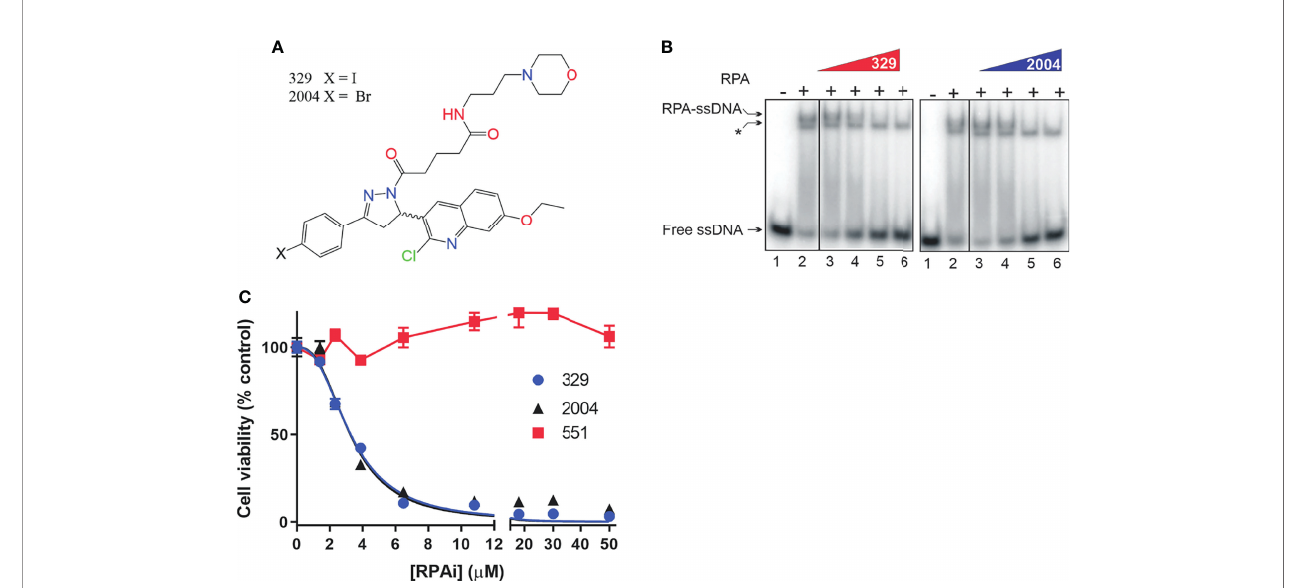
FIGURE 2 | Replication protein A inhibitor(RPAi) inhibitory activity. (A) Chemicalstructure of RPAi ’ s 329 and 2004 . (B) EMSA analysisof RPA – DNA interaction inhibition by 329 and 2004 . Lanes 3 – 6 ineach panelcontain 6.25, 12.5, 25, and 50 µM of the indicated RPAi,respectively.The * indicates the position of the Escherichia coli SSB – single- stranded DNA (ssDNA)complex that serves as an internal speci fi city control. (C) Cell viability of H460 NSCLCcellsinresponse to 329 and 2004 .